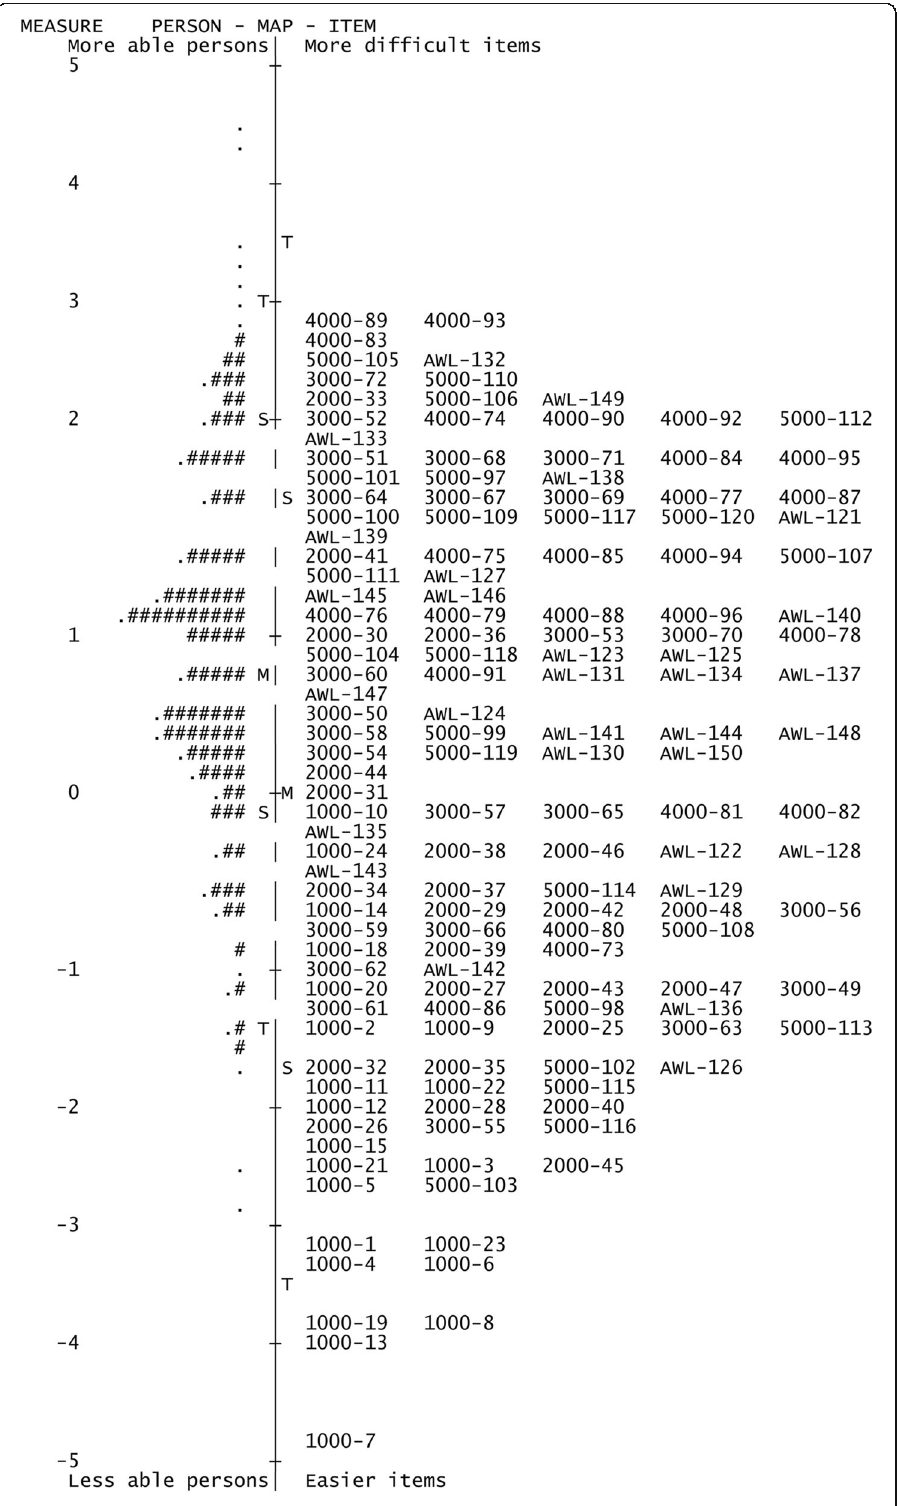
Fig. 1 Wright map of person and item measures. Note. Each “ # ” represents 3 persons and each “ . ” is 1 – 2 persons. M = Mean; S = 1SD; T = 2SD. AWL = Academic Word